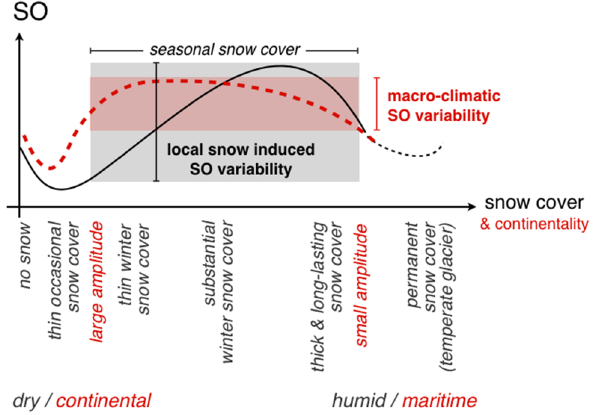
Figure 8. Qualitative sketch of the effect of snow cover and con- tinentality on the surface offset (SO): the dashed red line indicates the dependency on a macroclimatic continentality gradient (annual air temperature amplitude) correlated with an increase in precipita- tion (and snow thickness; strong seasonality of precipitation is ne- glected). The black line corresponds to the effect of local variations in snow accumulation (e.g. wind drift) with constant annual air tem- perature amplitude. While SO increases with snow-cover thickness for local variations until the effect of snow persistence reverses the trend, the continentality effect leads to a small variation of the SO for conditions with a seasonal snow